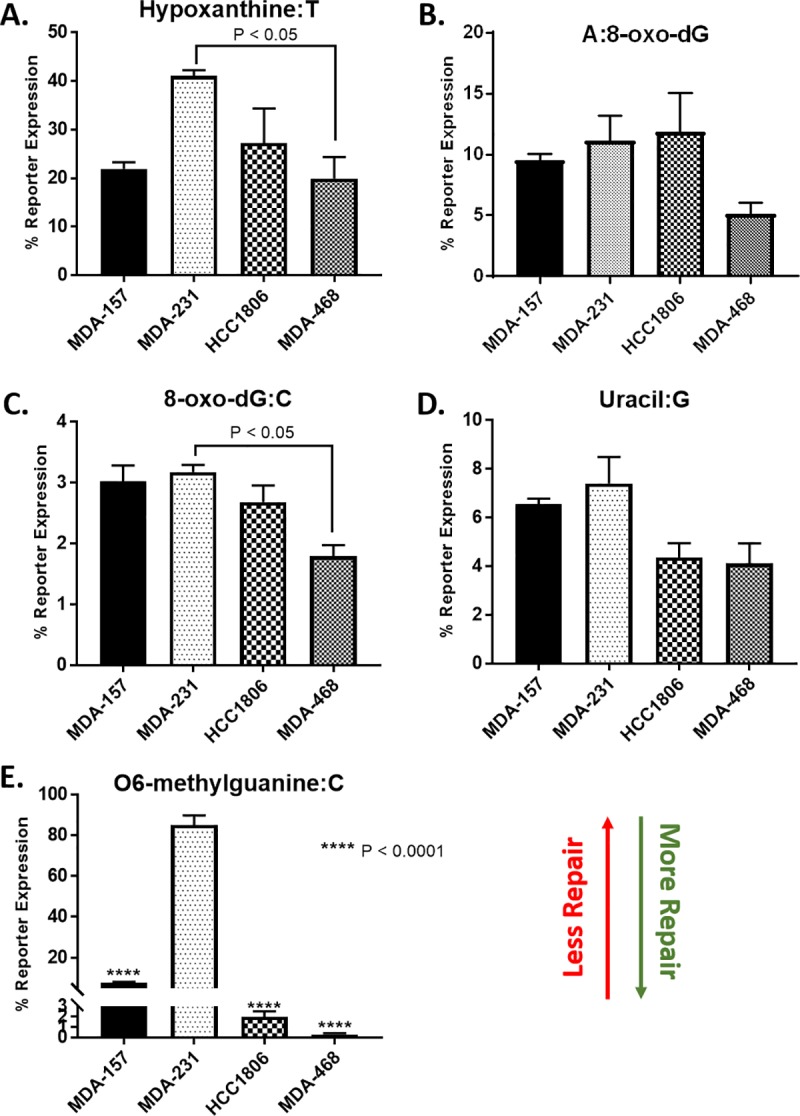
FM-HCR analysis of DNA repair capacity in TNBC cell lines.Cells were transfected with fluorescent reporter plasmids containing the indicated DNA lesions, A) Hypoxanthine:T (P < 0.05, MDA-231 to MDA-468), B) A:8-oxo-dG, C) 8-oxo-dG:C (P < 0.05, MDA-231 to MDA-468), D) Uracil:G, E) O6-methylguanine:C (**** P < 0.0001, MDA-157 to MDA-231, HCC1806 to MDA-231, MDA-468 to HCC1806), as well as an undamaged plasmid to normalize for transfection efficiency. DNA repair capacity is inversely proportional to % reporter expression.